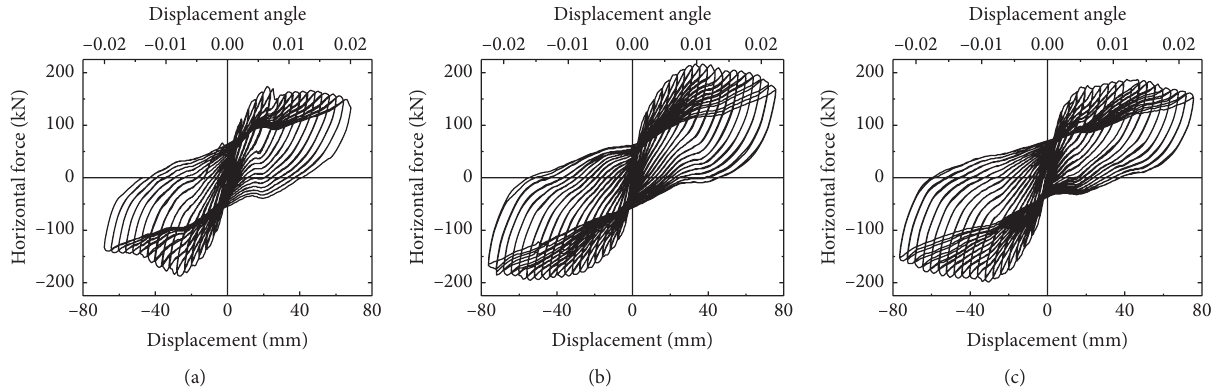
Figure 12: Comparison of hysteresis curves. (a) Hysteresis curve of XZ1. (b) Hysteresis curve of YZ1. (c) Hysteresis curve of